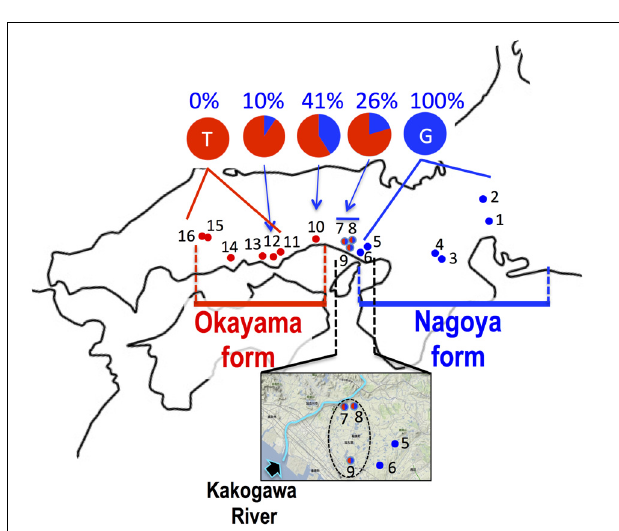
FIGURE 4 | Haplogroup of cytochrome b and frequency of haplotype at 233rd position of SOX3 in 16 populations of P. p. brevipodus . The red and blue circles indicate haplogroups of clade PB-O and PB-N, respectively. Red-blue (half-half) circles indicate sympatric distribution of the two haplogroups within a single population. The area including populations 5–9 are magnified with an arrow showing Kakogawa River. The frequencies of thymine and guanine haplotypes at 233rd positions of SOX3 are indicated in red and blue, respectively. See the localities (shown in number) in Table 1 .